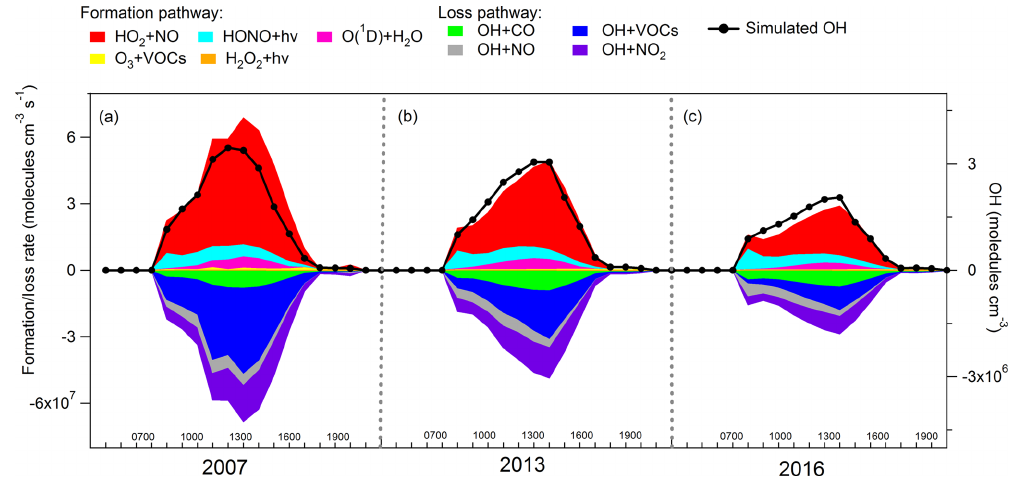
Figure 7. Average diurnal cycles of the OH formation and loss rates during the sampling periods in (a) 2007, (b) 2013 and (c)